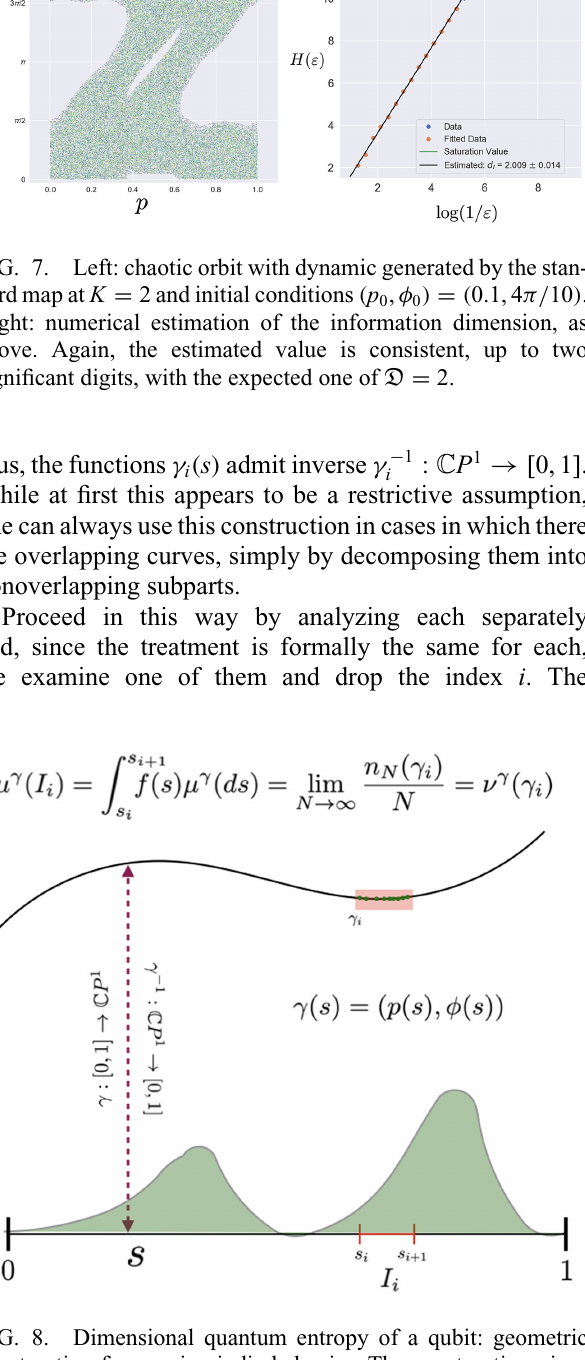
FIG. 8. Dimensional quantum entropy of a qubit: geometric construction for quasiperiodic behavior. The construction gives rise to a natural measure of dimension D = 1. The measure’s characteristics on C P 1 transfer to a random variable on the unit interval in a way that does not deform the distribution: it keeps intact the ratios ν γ (γ i )/ν γ (γ j ) = μ γ ( I i )/μ γ ( I j ) ≈ n (γ i )/ n (γ j ) . This holds thanks to the fact that D = 1 and therefore the sup- port of the measure is a curve γ on C P 1 that can always be parametrized by γ ( s ) with s ∈ [0, 1]. The green area represents a fictitious probability density on γ mapped onto [0,